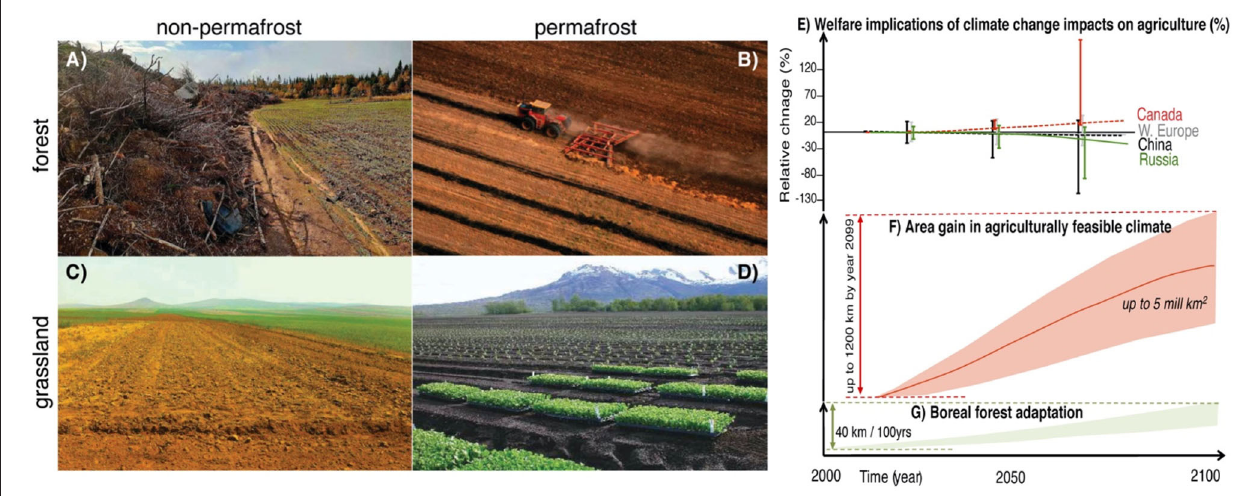
FIGURE 1 | Policies on agricultural land use and land use change in the northern regions respond to complex climatic, economic and societal circumstances. Shifts in land use to agriculture occur by converting boreal forests either on non-permafrost or permafrost lands or conversion of grasslands in regions contiguous to permafrost or on permafrost: (A) removal of boreal forest biomass and topsoil in Newfoundland, Canada, (B) former boreal forest, currently a tilled field, Alaska, USA, (C) large-scale plowing under of grassland, Mongolia, and (D) vegetables grown on former grasslands above permafrost, Alaska, USA; (E) The economic welfare implications of agriculture in the northern countries depend on a combination of agricultural productivity, market conditions, and export capacity/readiness of a particular region. The graphic summarizes the most likely relative change and the range of changes in economic welfare due to agriculture (adapted after Moore et al., 2017 ); (F) Climate change is expected to lead to an expansion of agriculturally feasible climate over an area of up to 5 million km 2 by the end of the twenty-first century, with linear northward shifts of up to 1,200km (King et al., 2018); (G) At the same time, the estimated nortward shift of the boreal forest under climatic changes is limited to about 40km over a century, significantly slower than the shift in climate ( Davis and Shaw, 2001) (G) . All photographs by the authors (AU, MZ,